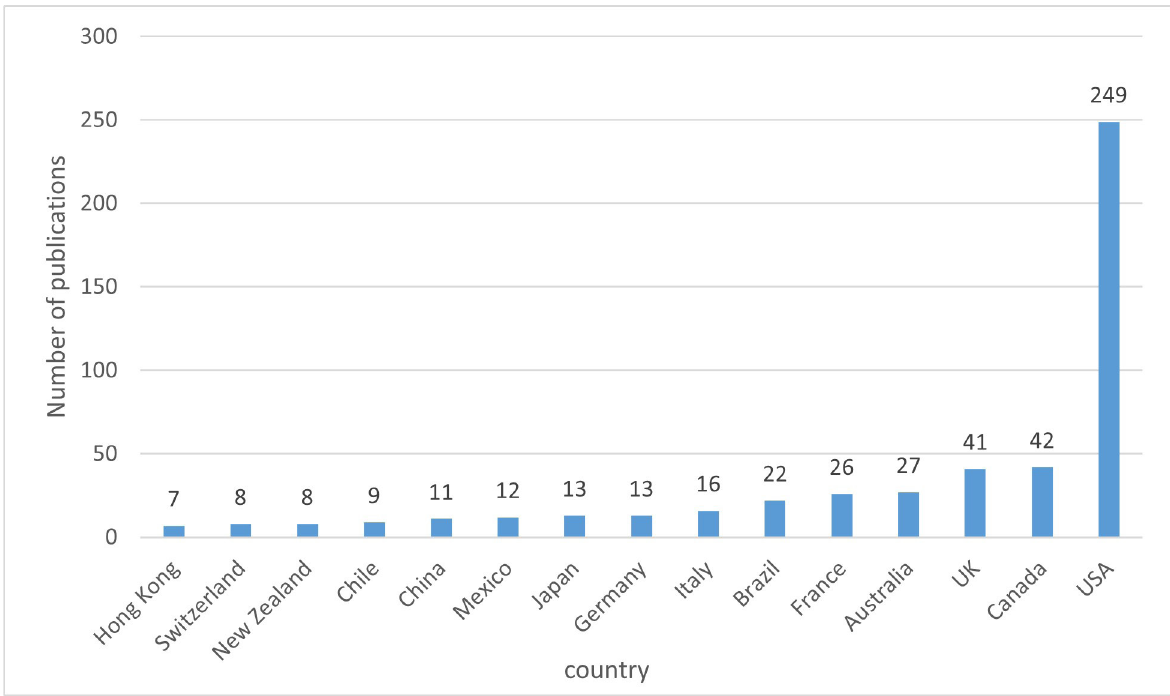
Figure 3. Countries that publish the